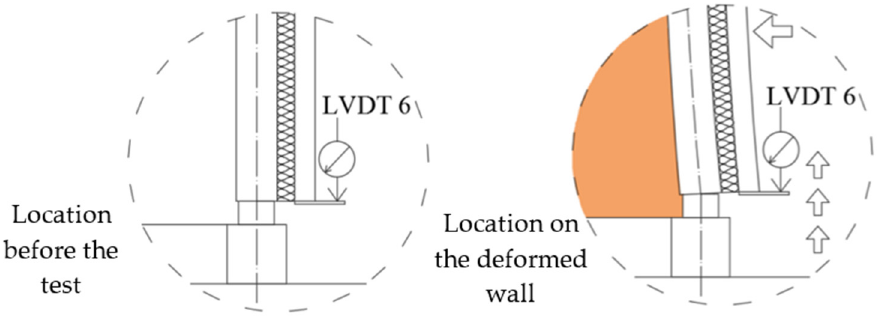
Figure 12. Location of the transducers for the measurement of the relative displacement of the facing wythe in the cases of Tests 1 and 3—an example from Test 1.